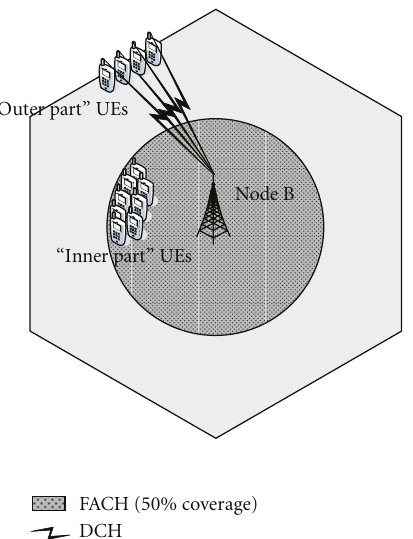
Figure 7: . MBMS provision with Mixed DCHs and FACH.